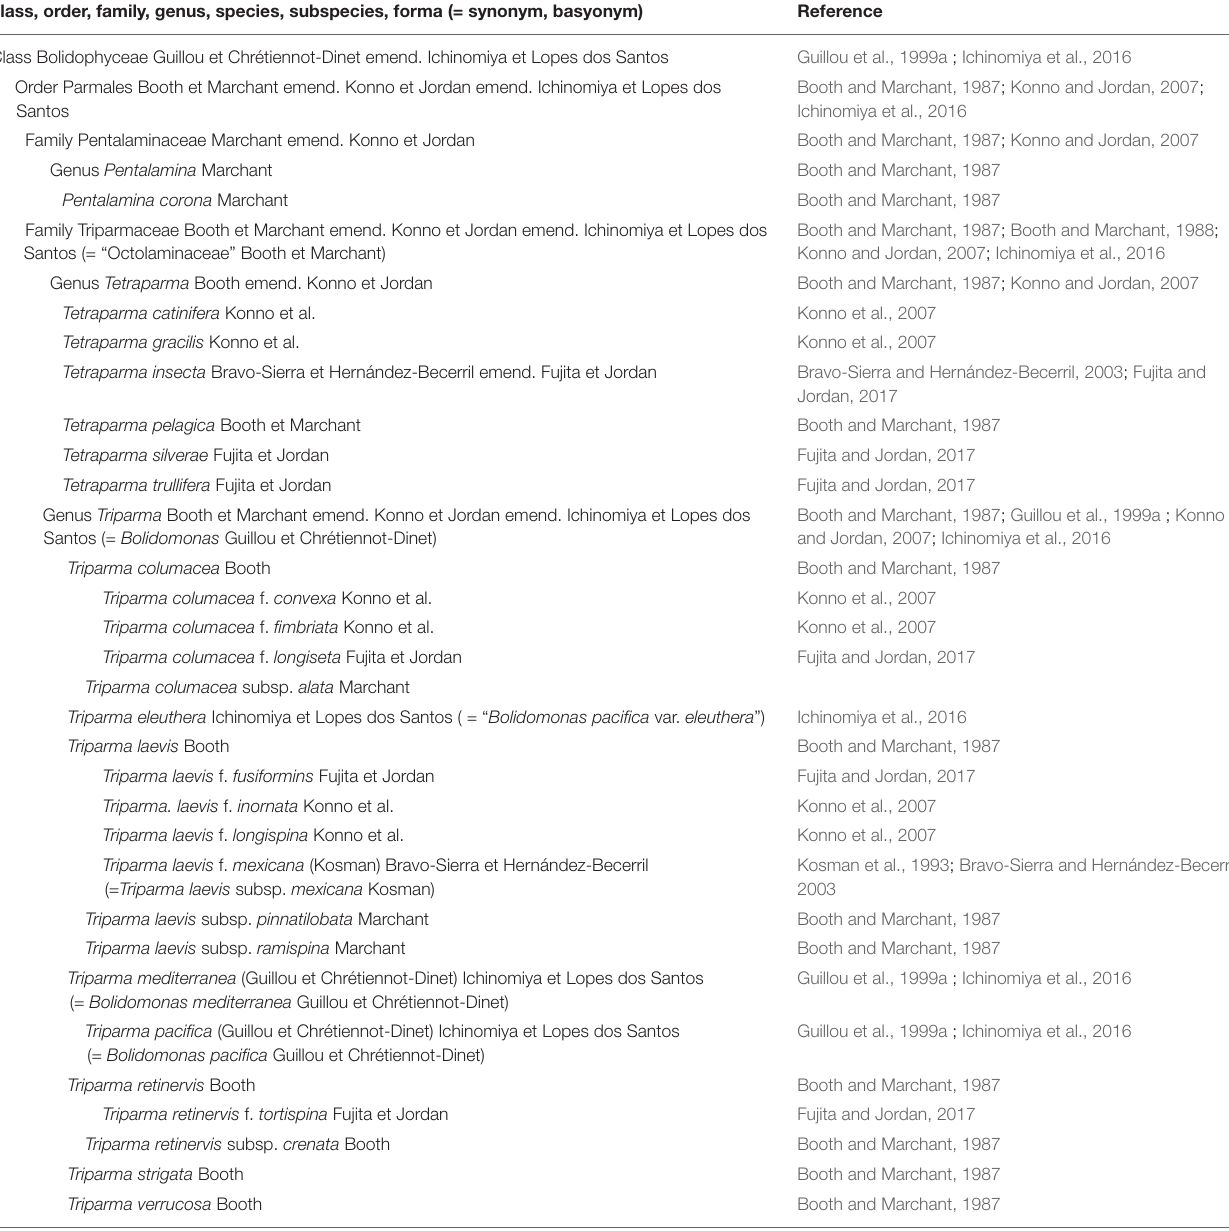
TABLE 1 | Current taxonomy of Bolidophyceae. class, order, family, genus, species, subspecies, forma (= synonym,